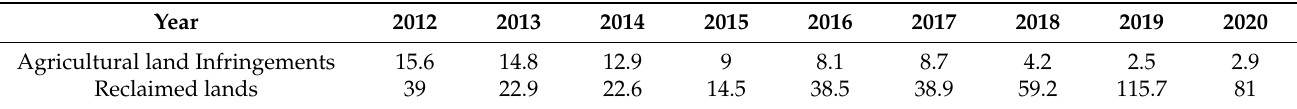
Table 1. Amount of annual infringement on agricultural land and reclaimed ones, by roughly one thousand acres—“feddan”